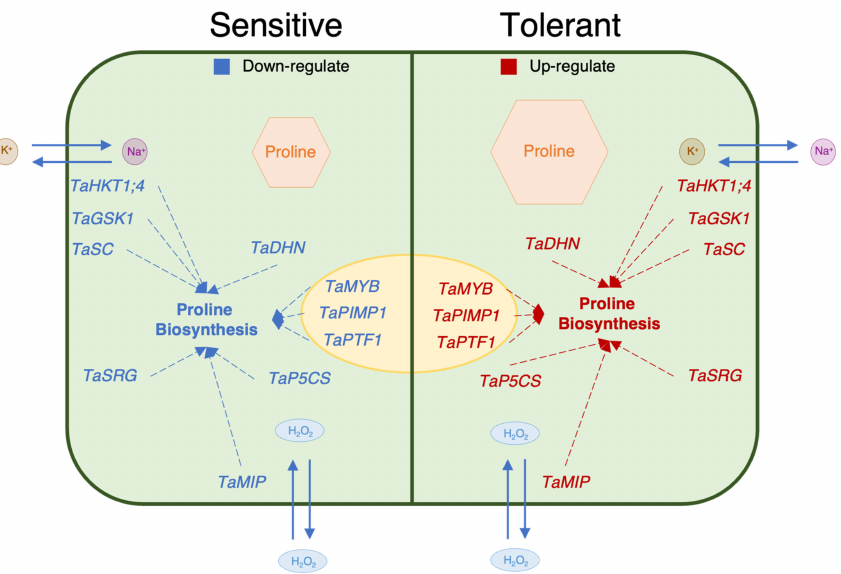
Figure 9. Suggested schematic illustration of a working model depicting the relationship between proline content and proline-related